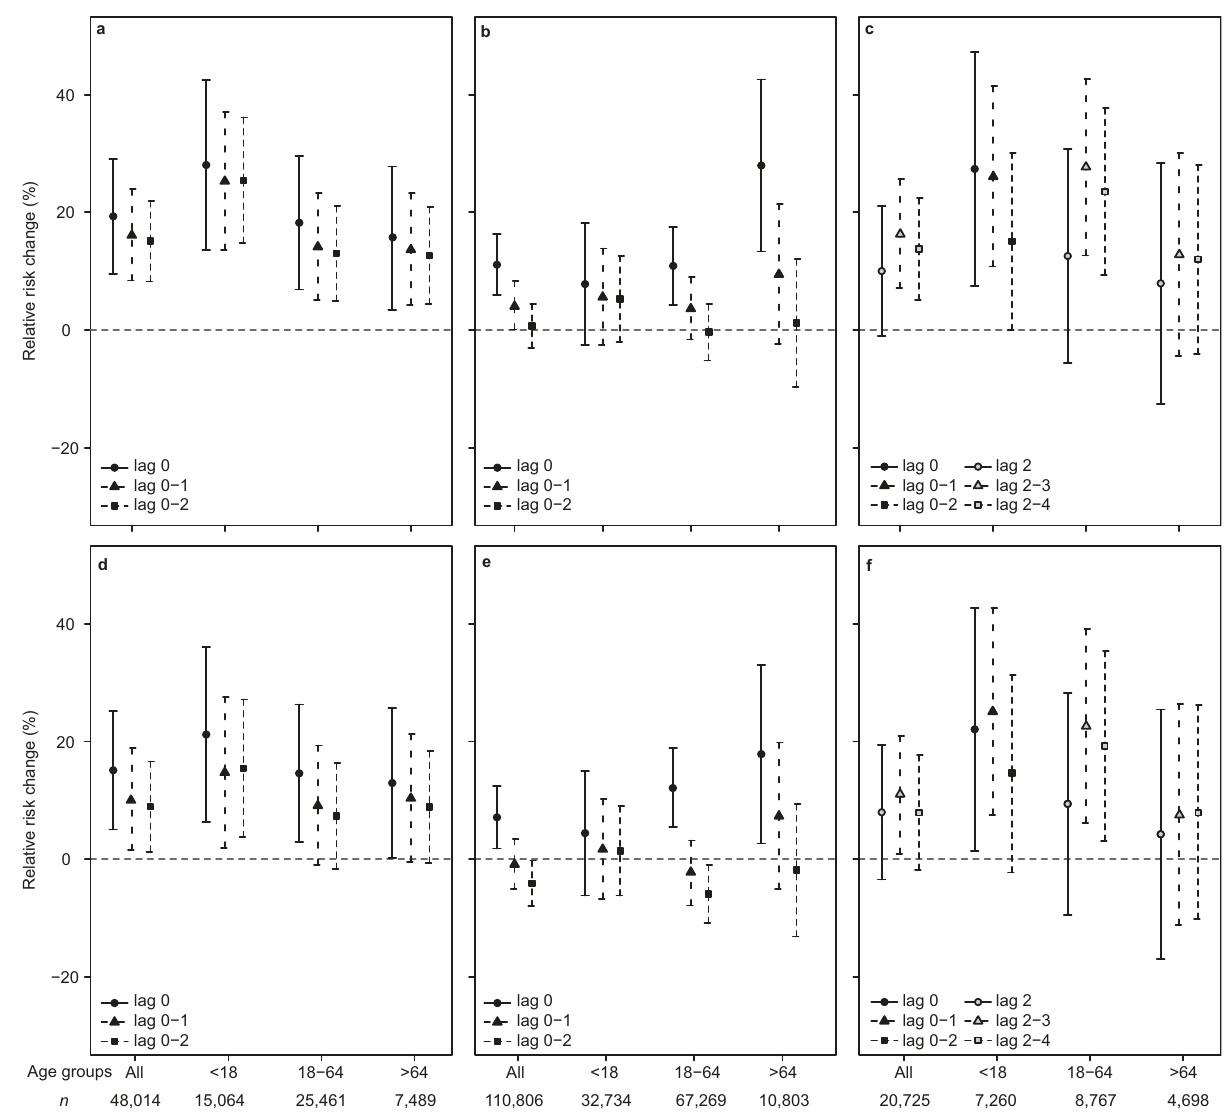
Fig. 2 Mature plume exposure and respiratory health outcomes. Associations between mature plume exposure and respiratory health outcomes from regression analysis for ( a , d ) AMD, n = 48,014 individuals; ( b , e ) PCMD, n = 110,806 individuals; ( c , f ) HED, n = 20,725 individuals. a – c Unadjusted results. d – f Results adjusted for SO 2 . Results are reported as percent change in RR with error bars showing the 95% con fi dence intervals. Results are shown for different age groups (all age groups combined; <18 years; 18 – 64 years; >64 years) for several lag combinations; n of individuals in each age group is shown on the x -axis. Lag 0 = the day of the exposure, lag 1 = one day after the exposure, lag 2 = two days after the exposure, lag 0 – 2 = mean of lag 0,